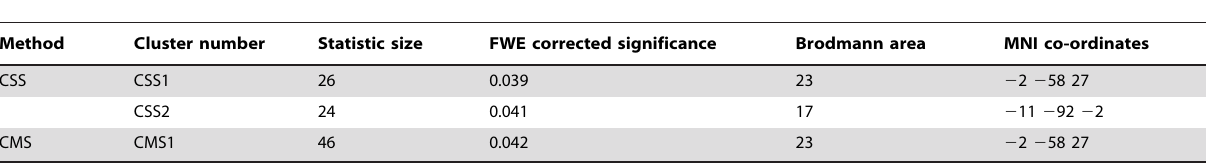
Table 1. Decreases in